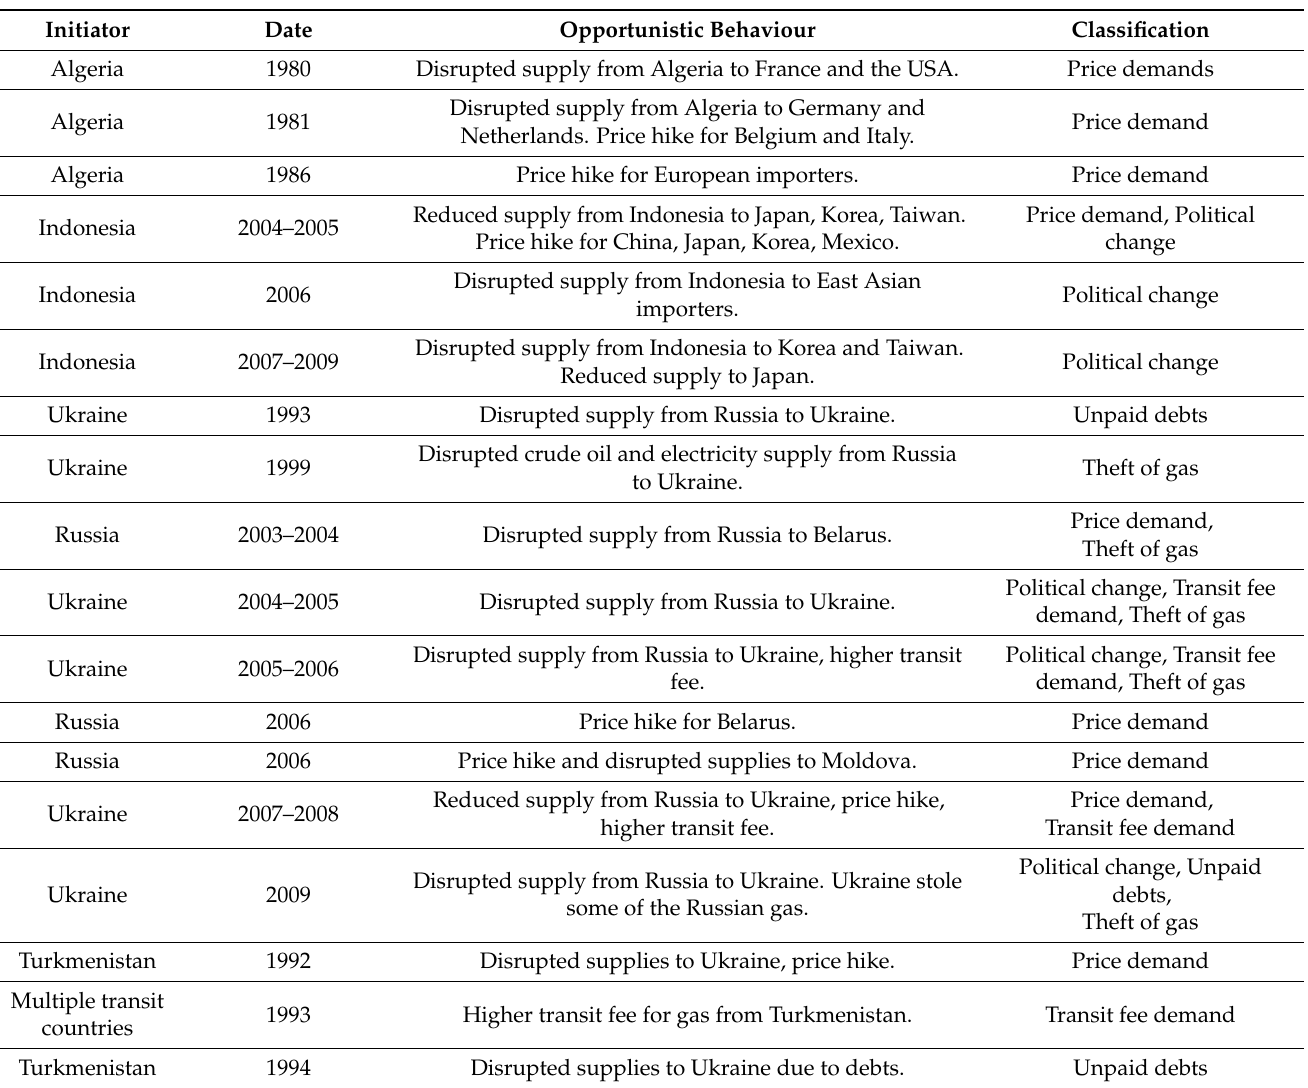
Table 1. Summary of